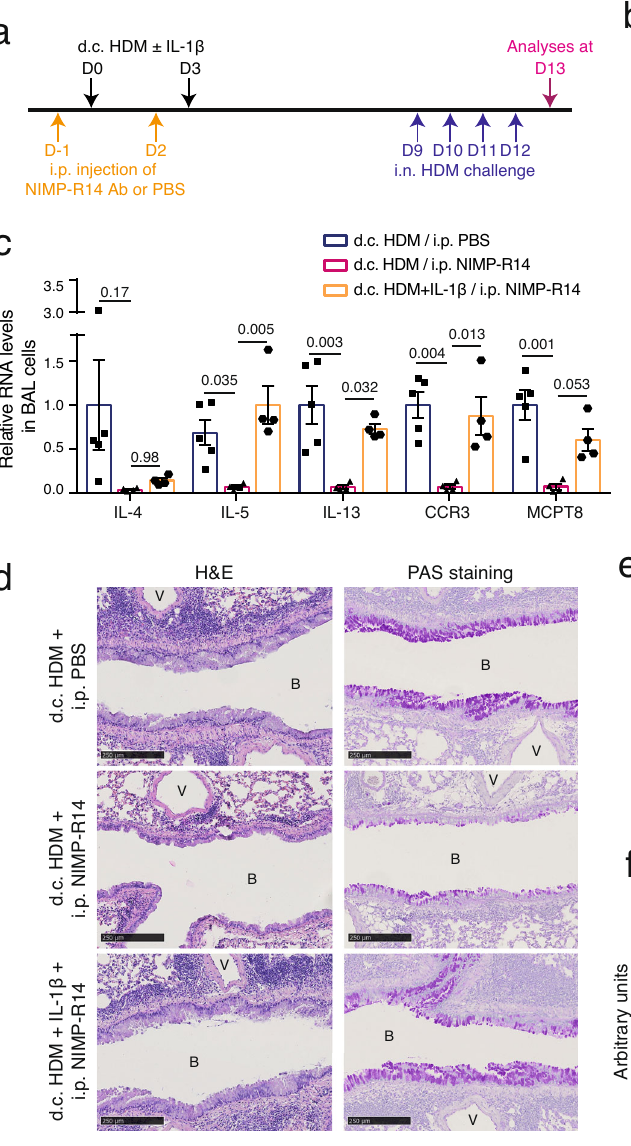
(H&E)orPeriodicAcidSchiff(PAS).B:bronchiole.V:bloodvessel.Bar=250 μ mfor all pictures. e Lung resistance (R L ) at the baseline (aerosol of PBS) and in response to aerosolized methacholine (Mch; 50mg/ml), measured by FlexiVent system ( n =4,5,4,5mice).Two-sidedStudent ’ s t test. f SerumlevelofHDM-speci fi cIgEand IgG1measuredbyELISA( n =5,4,5mice).Two-sidedMann – Whitneyranksumtest. NS, non-sensitized. Data are representative of 2 ( b – d , f ) or 1 ( e )